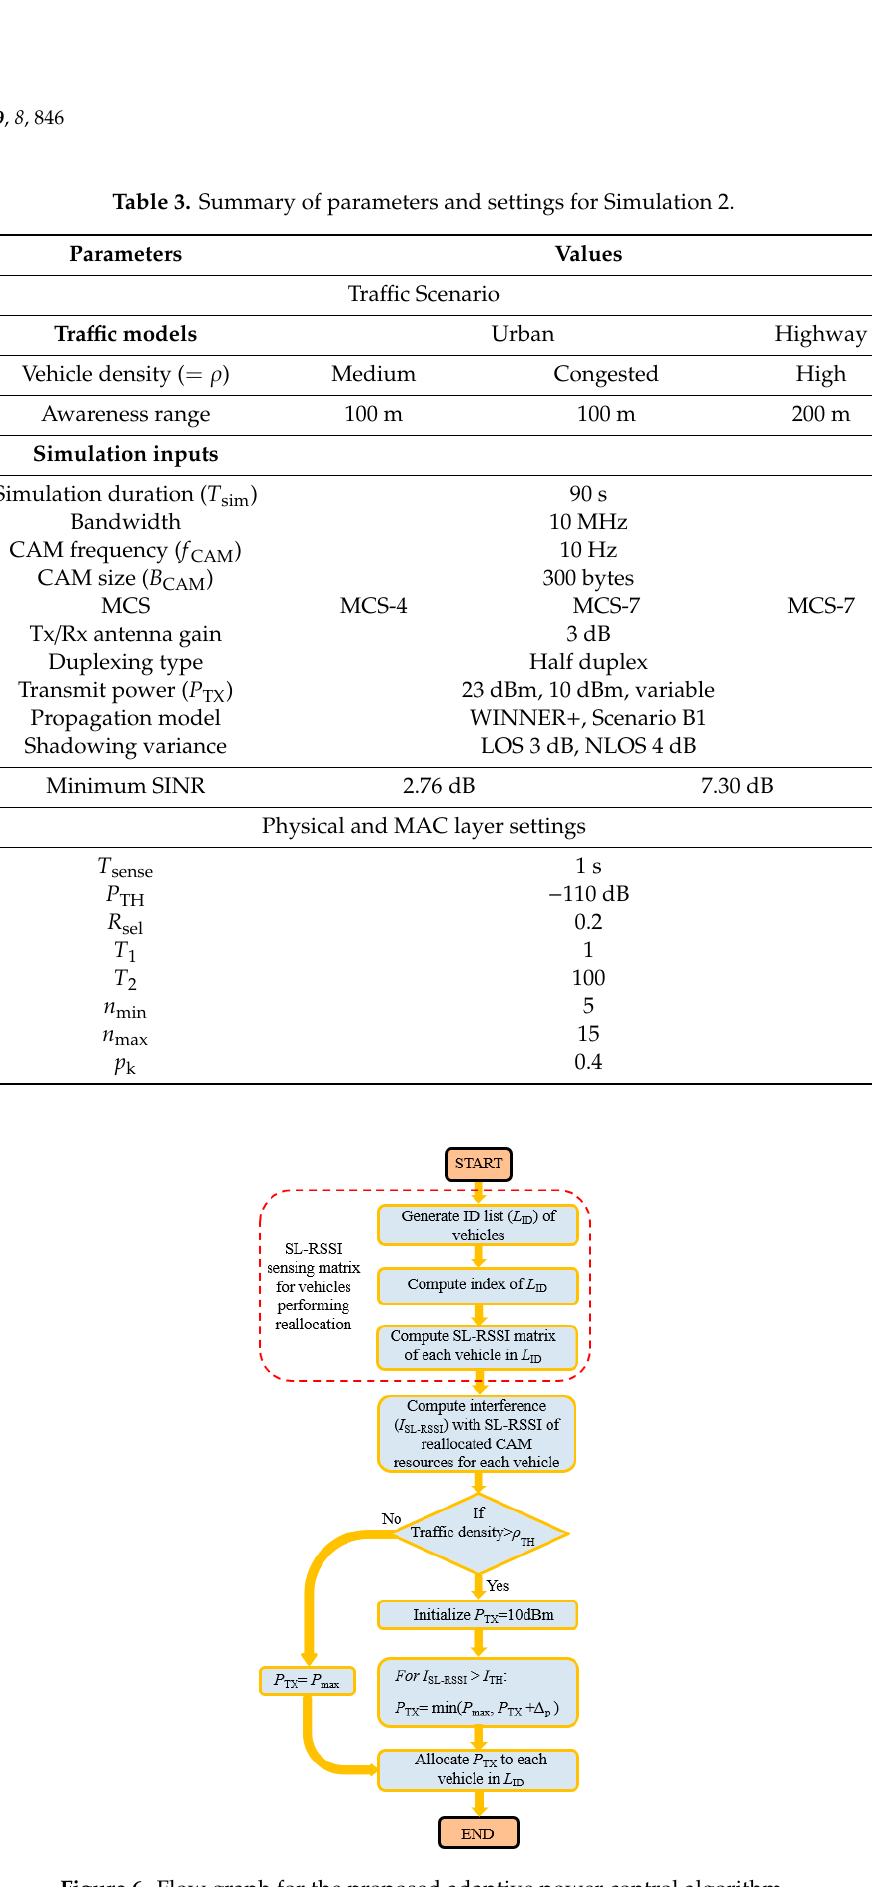
Figure 6. Flow graph for the proposed adaptive power control algorithm.